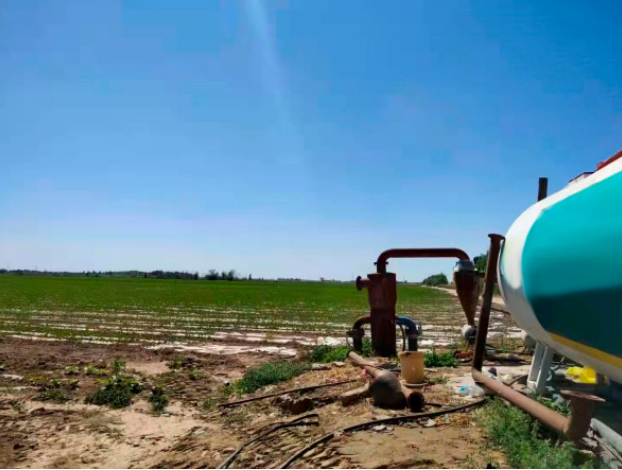
Figure 4. Experimental fertilizing equipment.